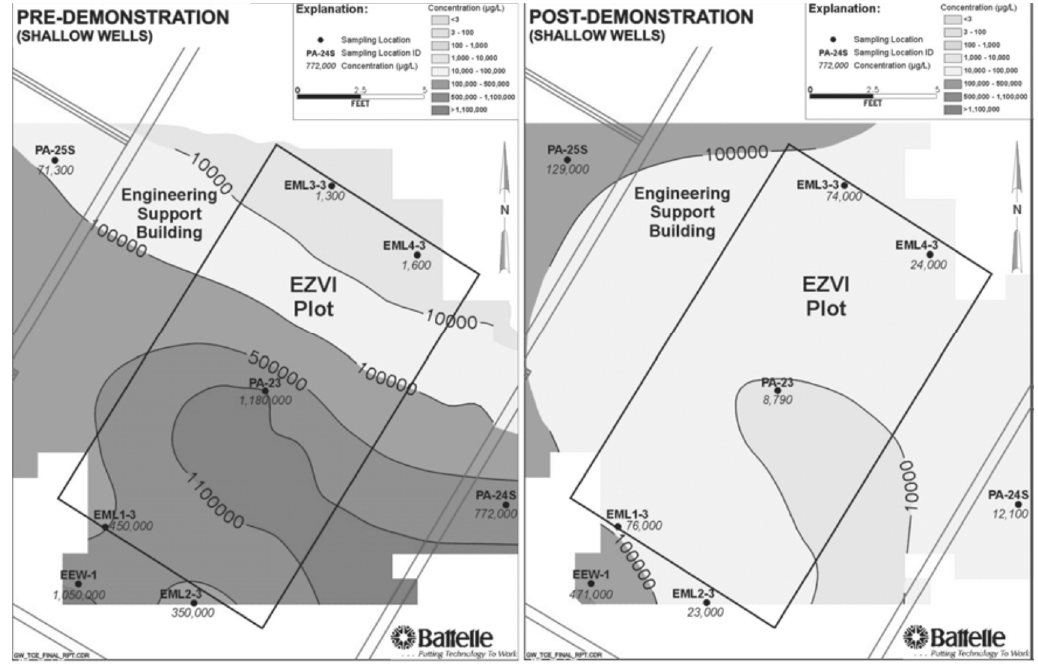
Figure 6. Scheme of the injection set-up. Reprinted with permission from Geiger et al. [105]. Copyright (2006) Wiley.